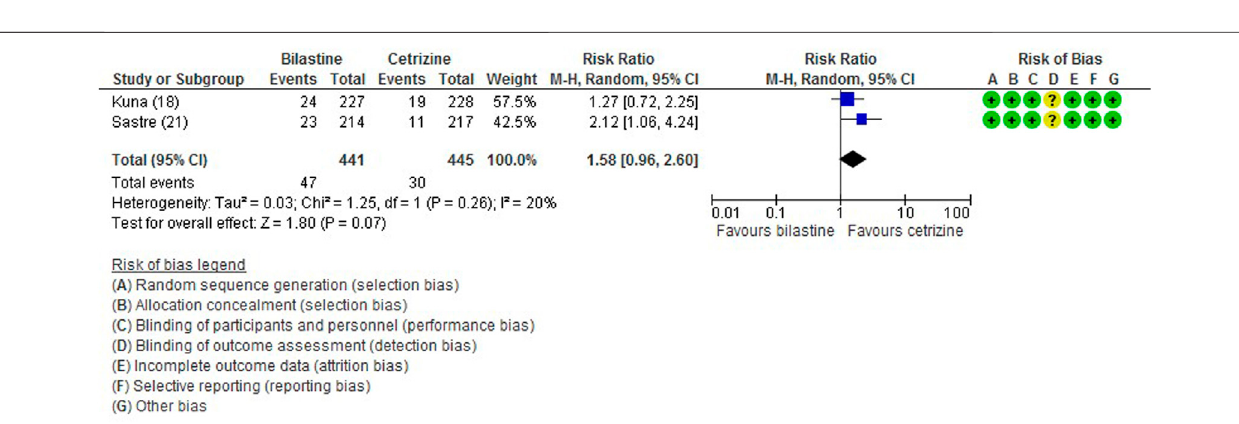
Frontiers in Pharmacology |